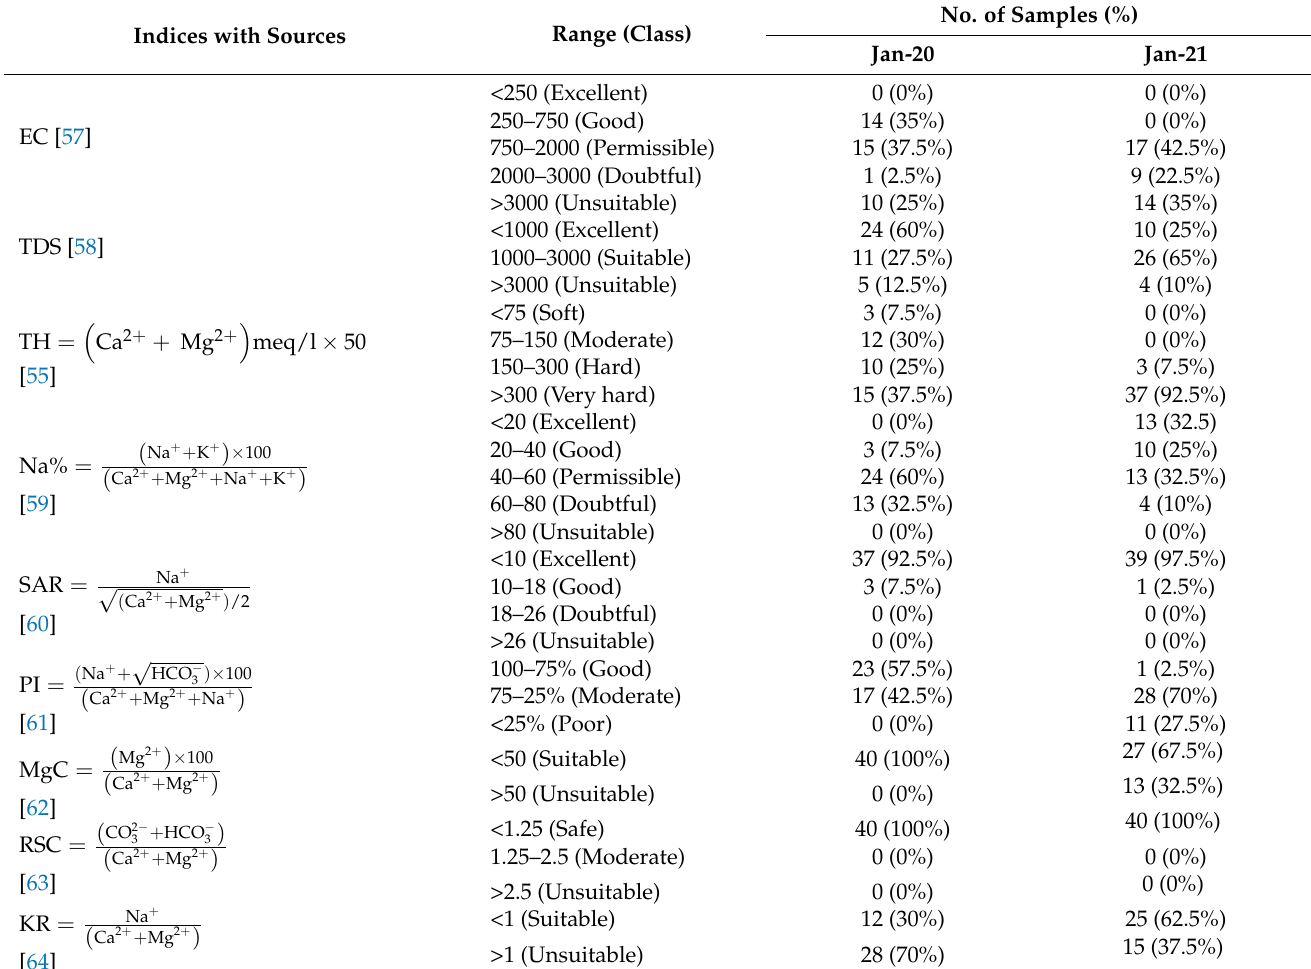
Table 3. Water quality classification for irrigation based on the determined